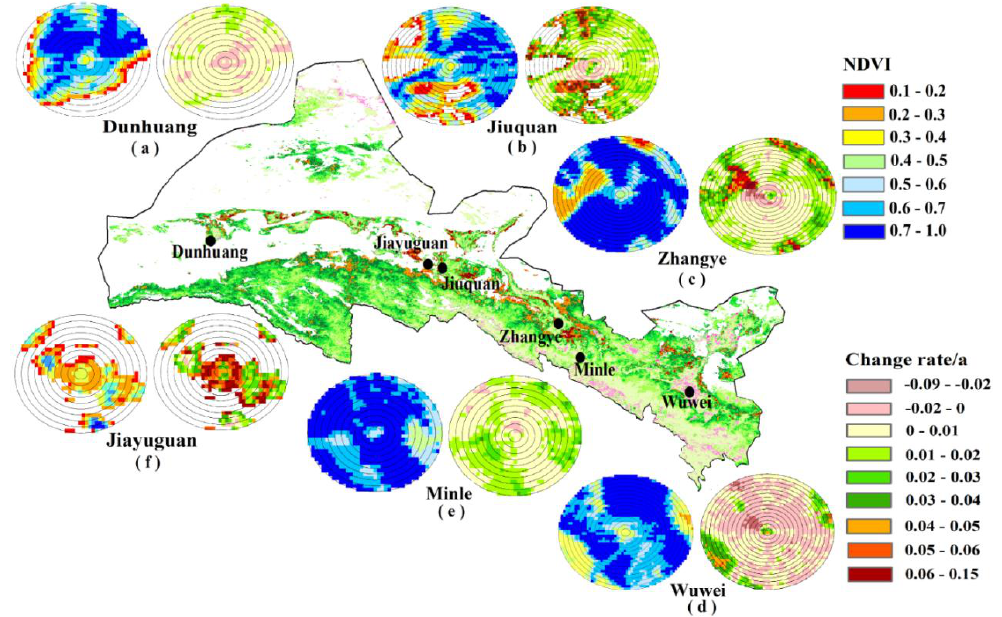
Figure 6. Spatial distributions of NDVI and linear change rate in the growing season NDVI around the Hexi Corridor and in the range of the buffer cities and counties ( a – f ) from 2000 to